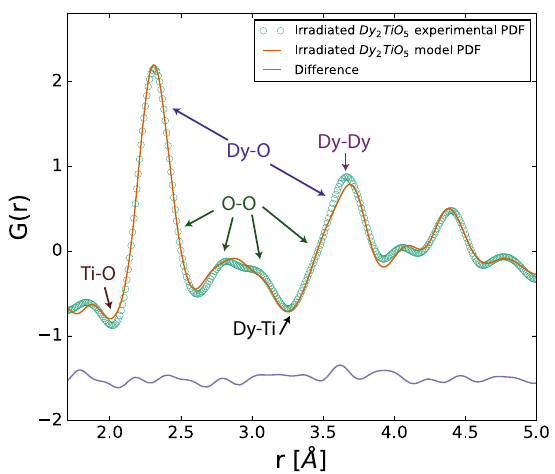
Fig. 6 Neutron PDF for irradiated Dy 2 TiO 5 with small-box re fi nement. The re fi nement based on the pristine orthorhombic structural model (orange line) describes the experimental data (green circles) well as indicated by the fl at difference curve (purple line). The major atomic correlations corresponding to peaks in the PDF for Dy 2 TiO 5 are labeled based on the applied structural